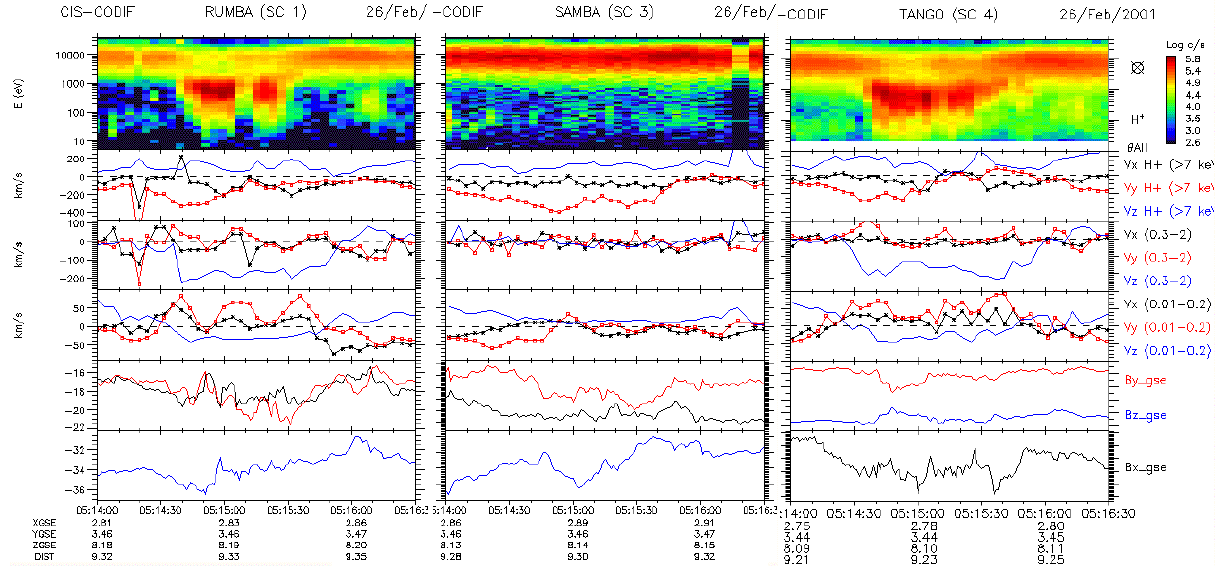
Fig. 2. A close-up view of one of the PTEs shown in Fig. 1 (26 February 2001) for the three s/c 1, 3 and 4. Upper panels give the energy-time spectrum of ions, panels 2 the flow velocity for > 7keV H + , panels 3 the flow velocity for 0.3–5keV H + , panels 4 the flow for < 0.2keV H + and the bottom two panels the magnetic field components in GSE